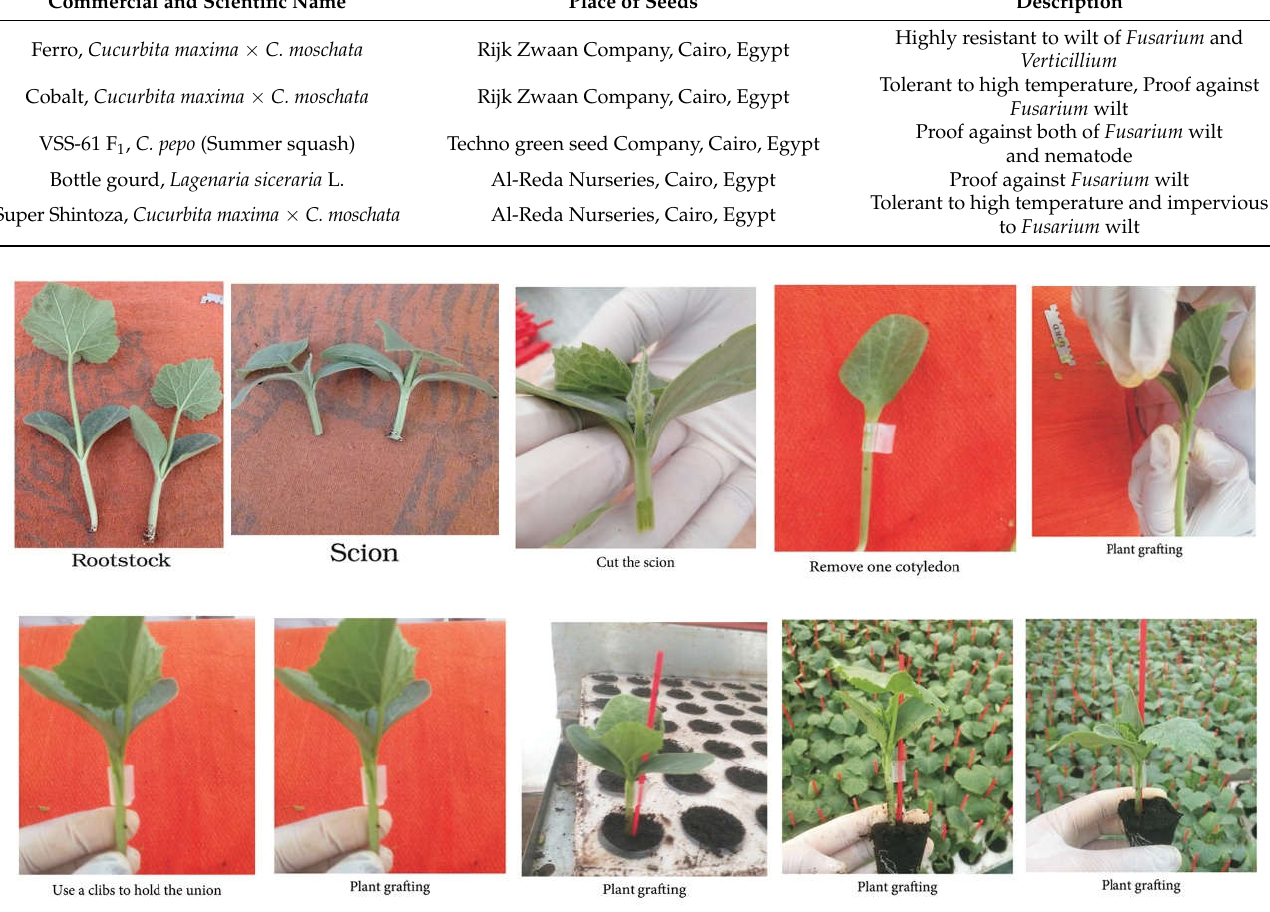
Figure 6. Slant cut grafting method used in grafting for the current study, including the following steps: prepare both the rootstock and scion, then cut the scion, remove one cotyledon of rootstock, match the cut surfaces on the scion and rootstock, use a clip to hold the union and then produce the grafted seedlings (photos by authors). Table 4. Details of five cucurbit rootstocks used in our study.